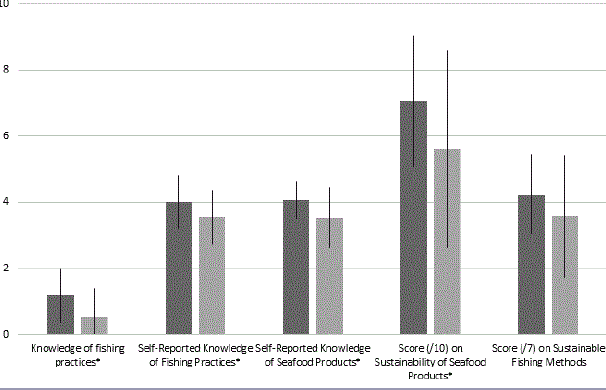
Fig. 1 . Relationship between environmental knowledge attitude and Ocean Wise